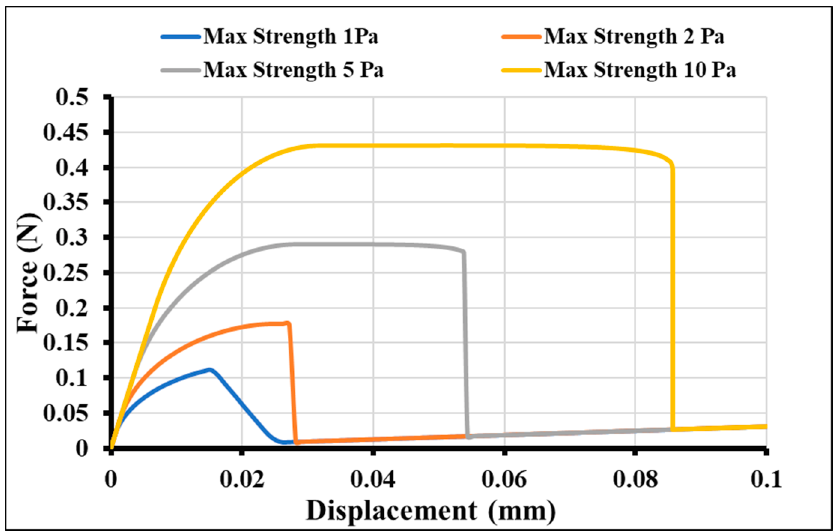
Figure 6. Force-displacement curve for varying cohesive strength.